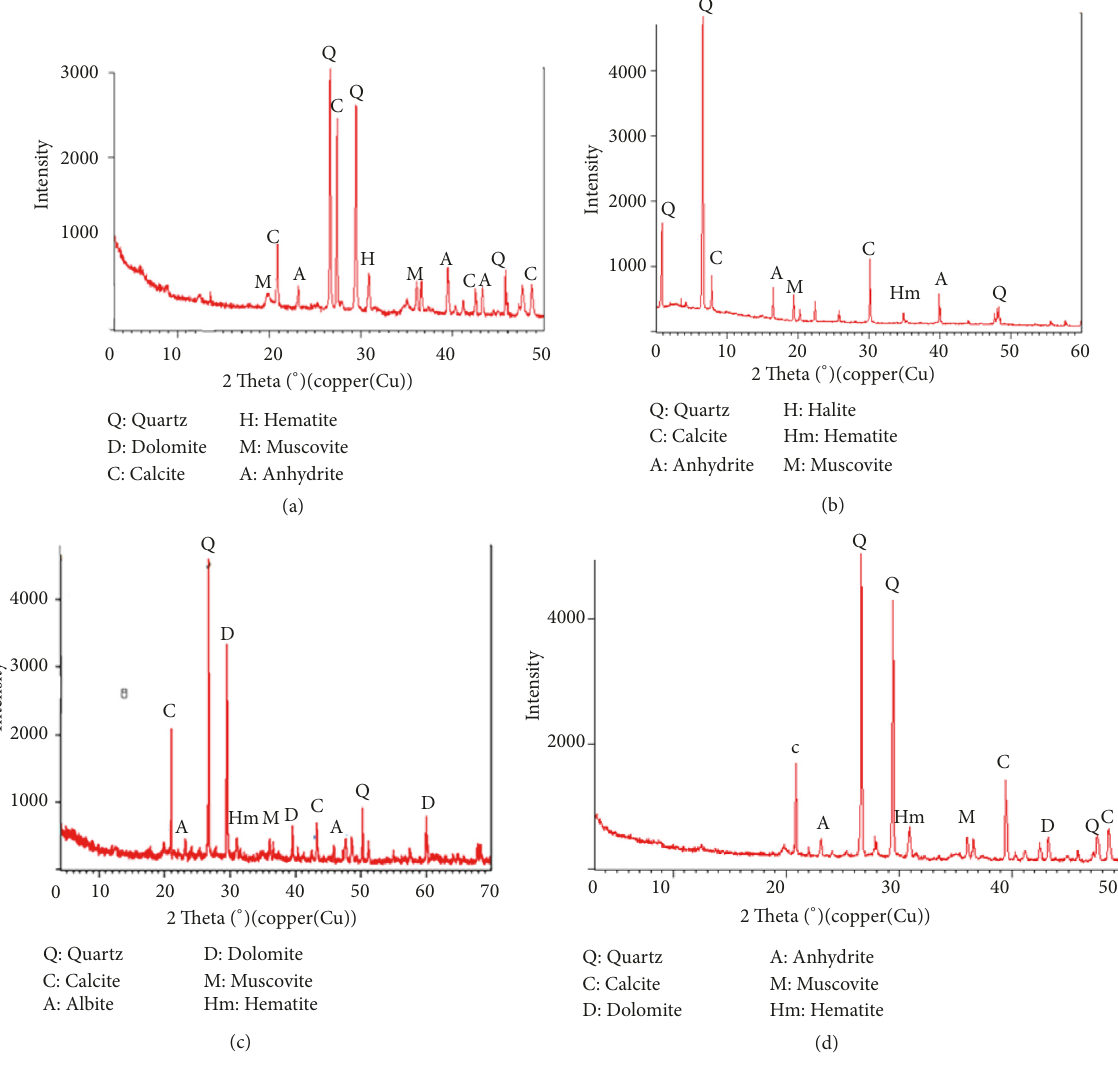
Figure 1: Mineralogical analysis by diffraction of x-rays of the sediments of various stations: (a) sample of the station N ∘ 1, (b) sample of the station N ∘ 2, (c) sample of the station N ∘ 3, and (d) sample of the station N ∘ 4.